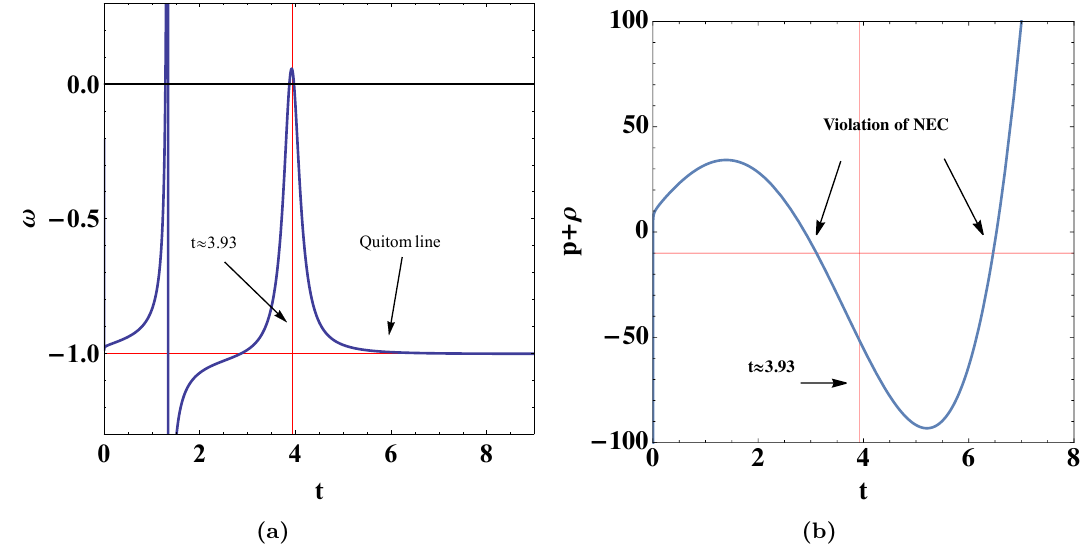
Figure 4. Evolution of the equation of state (EoS) parameter ω and the Null energy condition ( NEC : p + ρ ) as a function of the cosmic time t